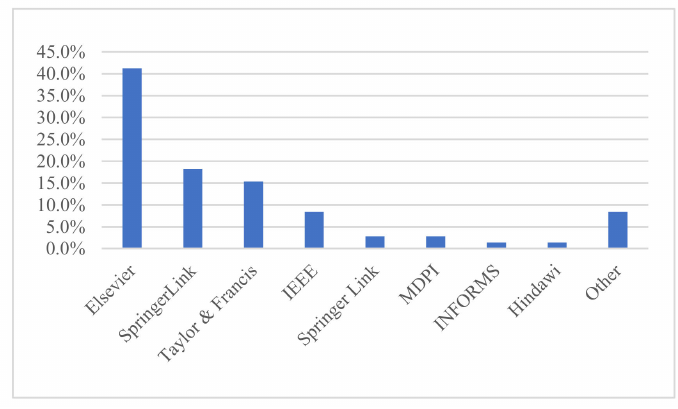
Figure 3. Breakdown of dataset by publisher.